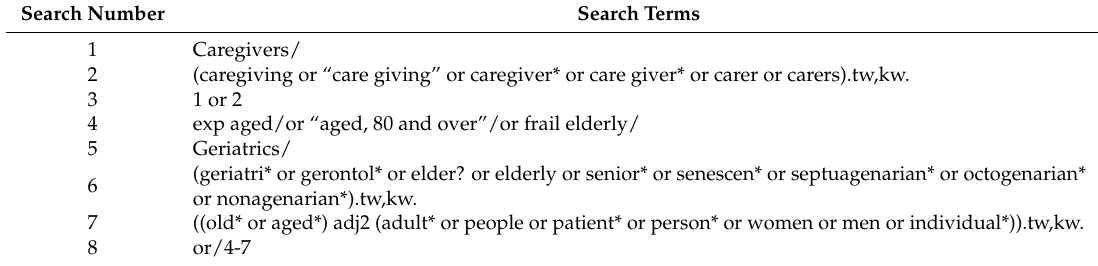
Table A1. Medline search strategy. The asterisks (*) were used to retrieve variations on a distinctive word stem or